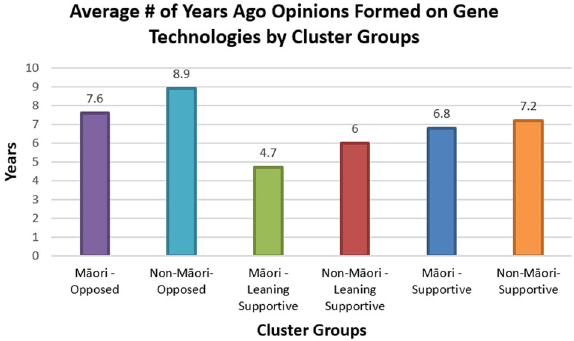
Fig. 5 Average no. of years since opinions on genetic technologies had been formed. The fi gure shows how long ago opinions about genetic technologies were formed. This varied by cluster types. Non-M ā ori Strongly Supportive are shown in orange, M ā ori Strongly Supportive dark blue, non- M ā ori Leaning Supportive red, M ā ori Leaning Supportive green, non-M ā ori Opposed light blue, and M ā ori Strongly Opposed purple.